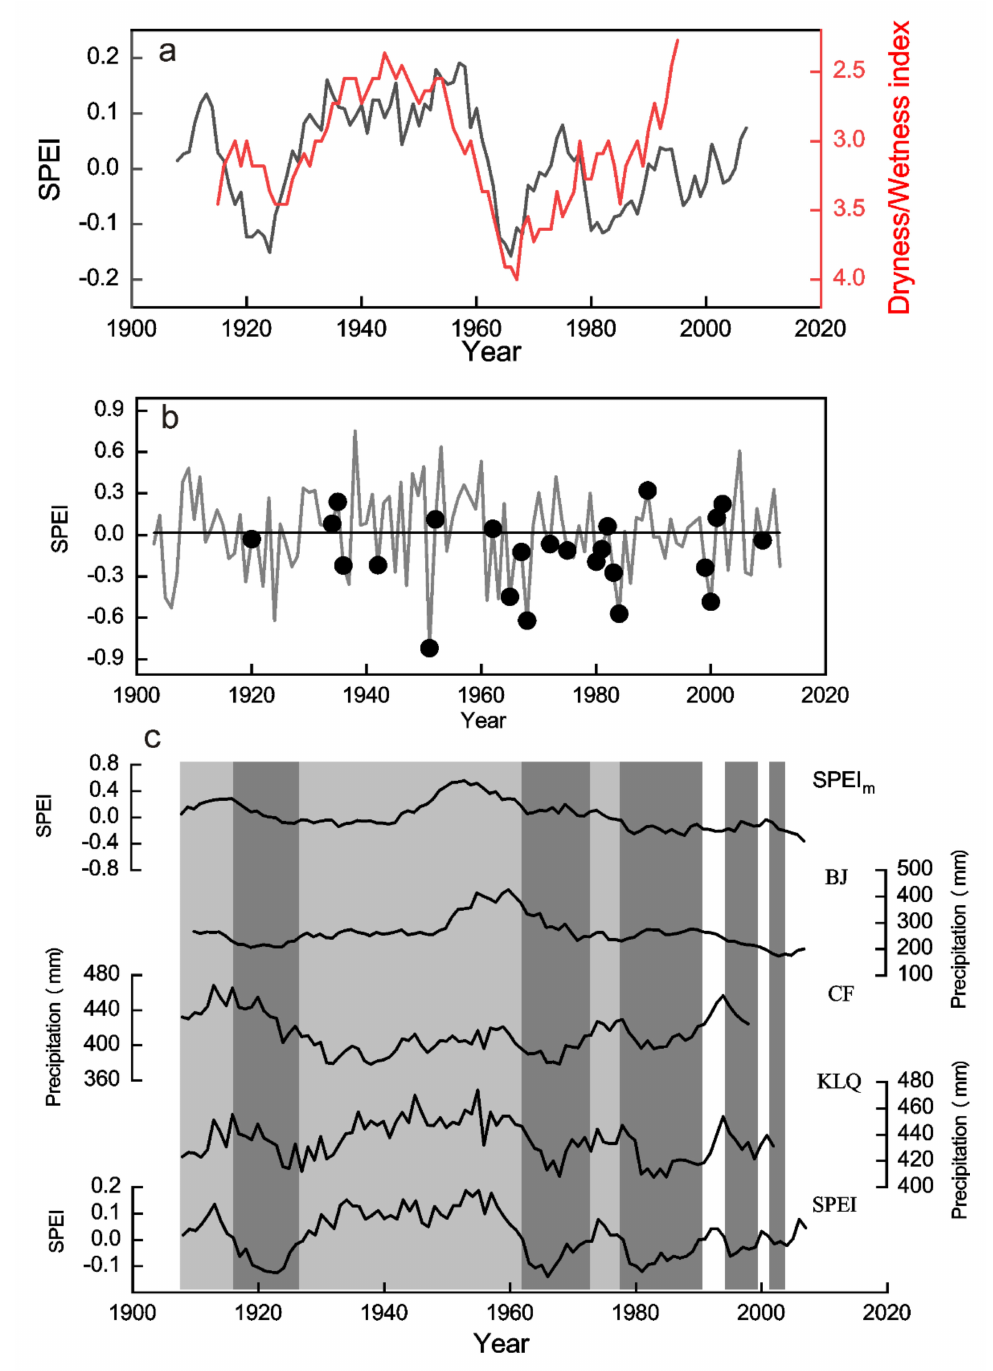
Figure 9. Comparisons with other proxy records. ( a ) Comparison between the SPEI 82 reconstruction (black line) and dryness/wetness indices at Duolun (red line). ( b ) Comparison between the SPEI 82 reconstruction and drought events (dots) (horizontal line is the averaged SPEI 82 from 1903 to 2012). ( c ) Comparison of the average SPEI from August of the previous year to February of the current year from the 12 grid points (SPEIm) (http://climexp.knmi.nl, accessed on 16 January 2022) covering the three stations, the precipitation observations from August of the previous year to February of the current year from the Beijing meteorological station (BJ), the precipitation from August of the previous year to July of the current year at Chifeng-Weichang (CW) and Kalaqin (KLQ) and the SPEI 82 reconstruction (SPEI). (The smoothed line is an 11-year moving average, and the dark/light gray shadow areas represent the same dry/wet periods in different